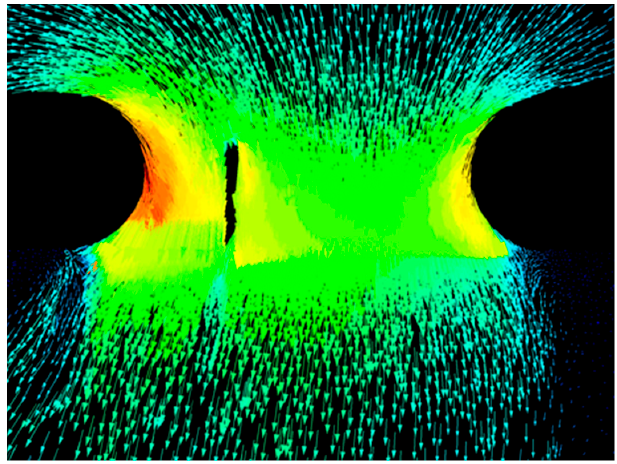
Figure 8. Velocity vector in the central plane of the aircraft to show the actual diffusion angle at the outlet of the annular duct; left is the outer duct wall, right is the inner duct wall, and in the middle is the baffle. The colors mean the magnitude of velocity. Red means high velocity and blue means low.